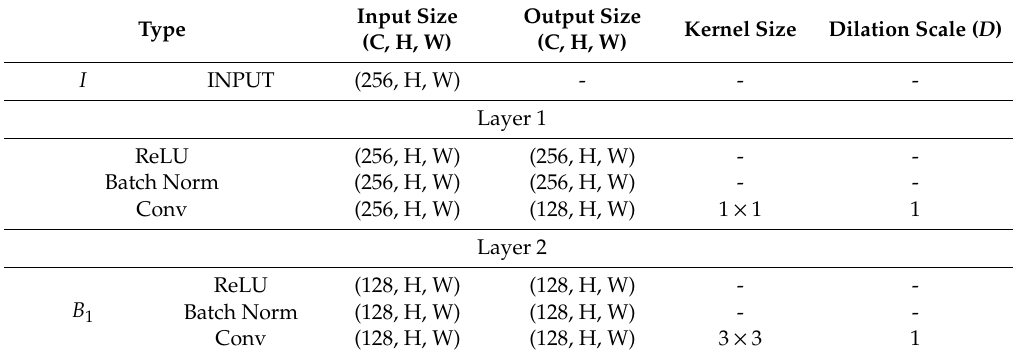
Table 1. Proposed multidilated light residual block